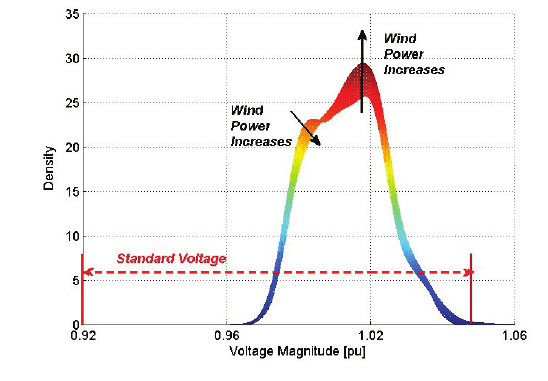
Figure 6. Impact of wind generation variability on voltage regulation in the FirstEnergy/PJM transmission